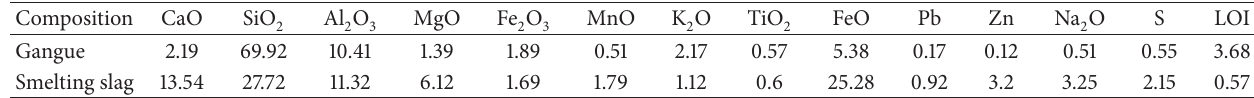
Table 1: Chemical composition of raw materials/%.